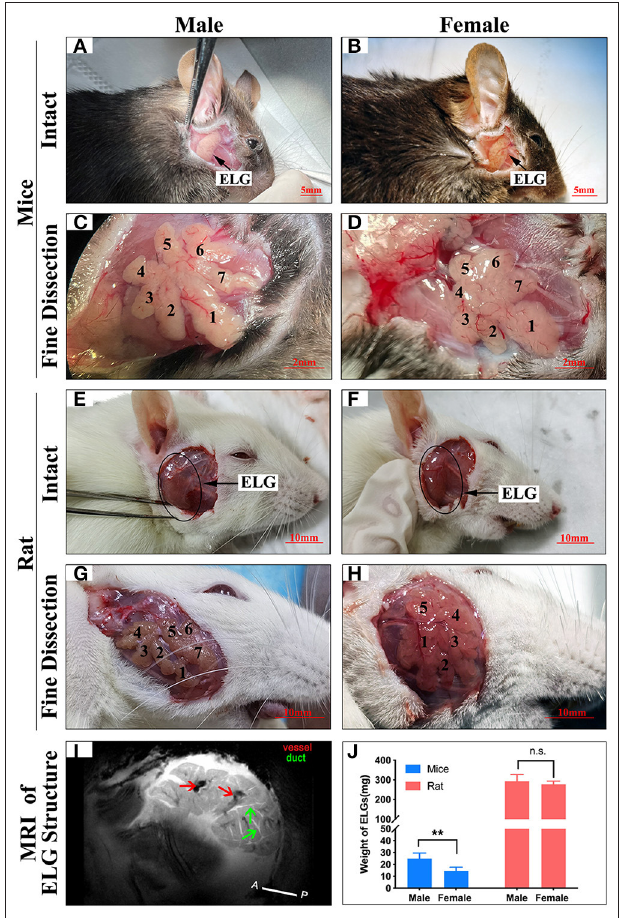
FIGURE 7 | Anatomy of ELGs. Entire appearance on ELGs on the face of (A) Male mice (scale bar = 5mm), (B) Female mice (scale bar = 5mm), (E) Male rat (scale bar = 10mm), (F) Female rat (scale bar = 10mm). ELGs locations are labeled by an arrow and blank circle in mice and rats, respectively. Fine dissection of ELG on the face of (C) Male mice (scale bar = 2mm), (D) Female mice (scale bar = 2mm), (G) Male rat (scale bar = 10mm), (H) Female rat (scale bar = 10mm). (Figure is labeled on each lobe of ELG). (I) T2 anatomical MRI of rat’s ELG (horizontal section). The red arrows point to the blood vessels, and the green arrows point to the ducts. (J) Weight of ELGs isolated from animals. The values are presented as the means ± SEM, ** p < 0.01 , n.s., no significant difference.